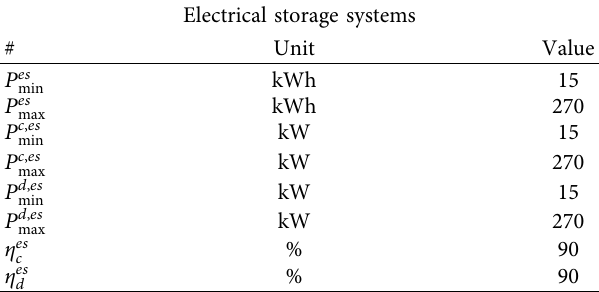
Table 1: Technical parameters of the electrical storage system.